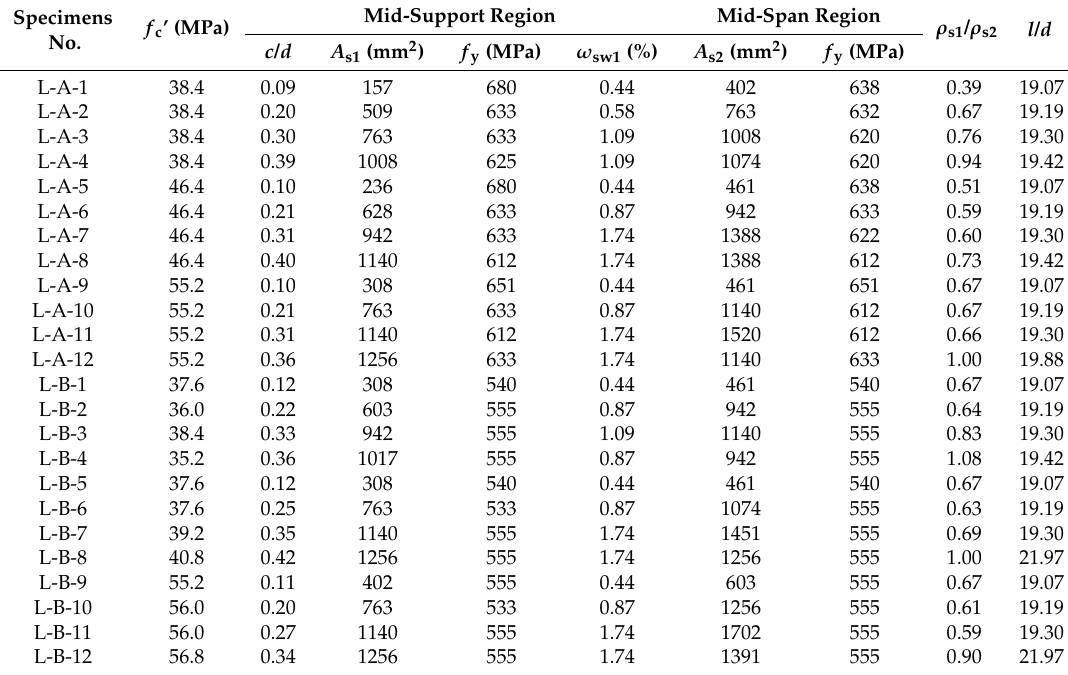
Figure 1. Reinforcement arrangement of: ( a ) continuous beams; and ( b ) continuous frames. Table 2. Details of 24 continuous beams.